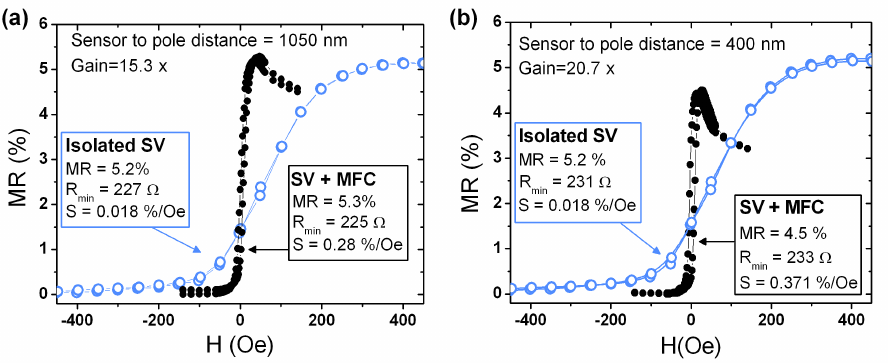
Figure 4. Transfer curves (I bias = 100 µ A) for selected devices displaying the maximum sensitivity gain achieved, comparison the isolated SV curve with the corresponding device including the MFCs with a pole to sensor distance of ( a ) 1050 nm, the largest fabricated and ( b ) 400 nm, the smallest fabricated.